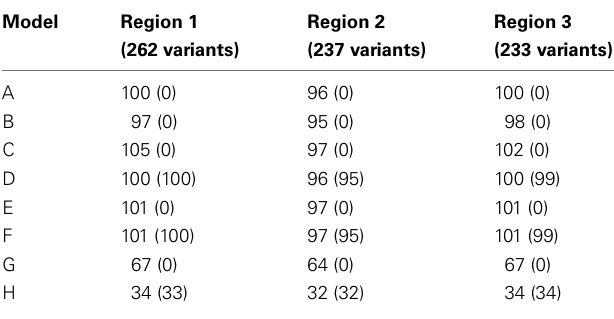
Table 1 | Summary of models used in Simulation study I and II. Simulation study Model Type of causal variants MAF of